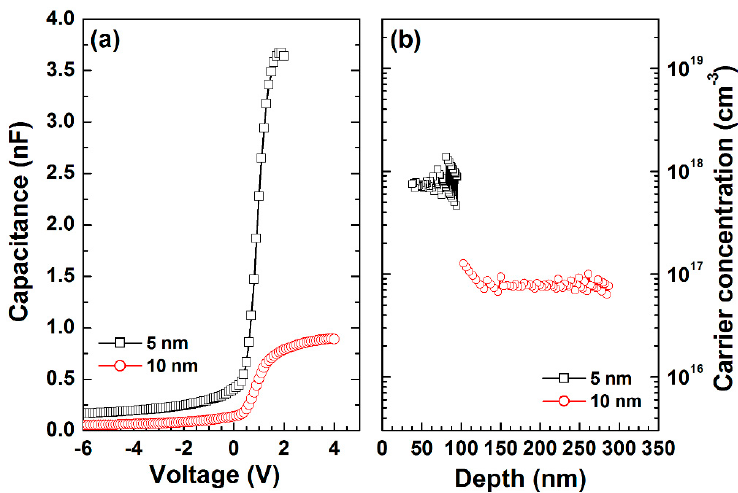
Figure 8. ( a ) Capacitance–voltage ( C – V ) characteristics measured at 100 kHz and ( b ) carrier concentration profiles vs. depth.